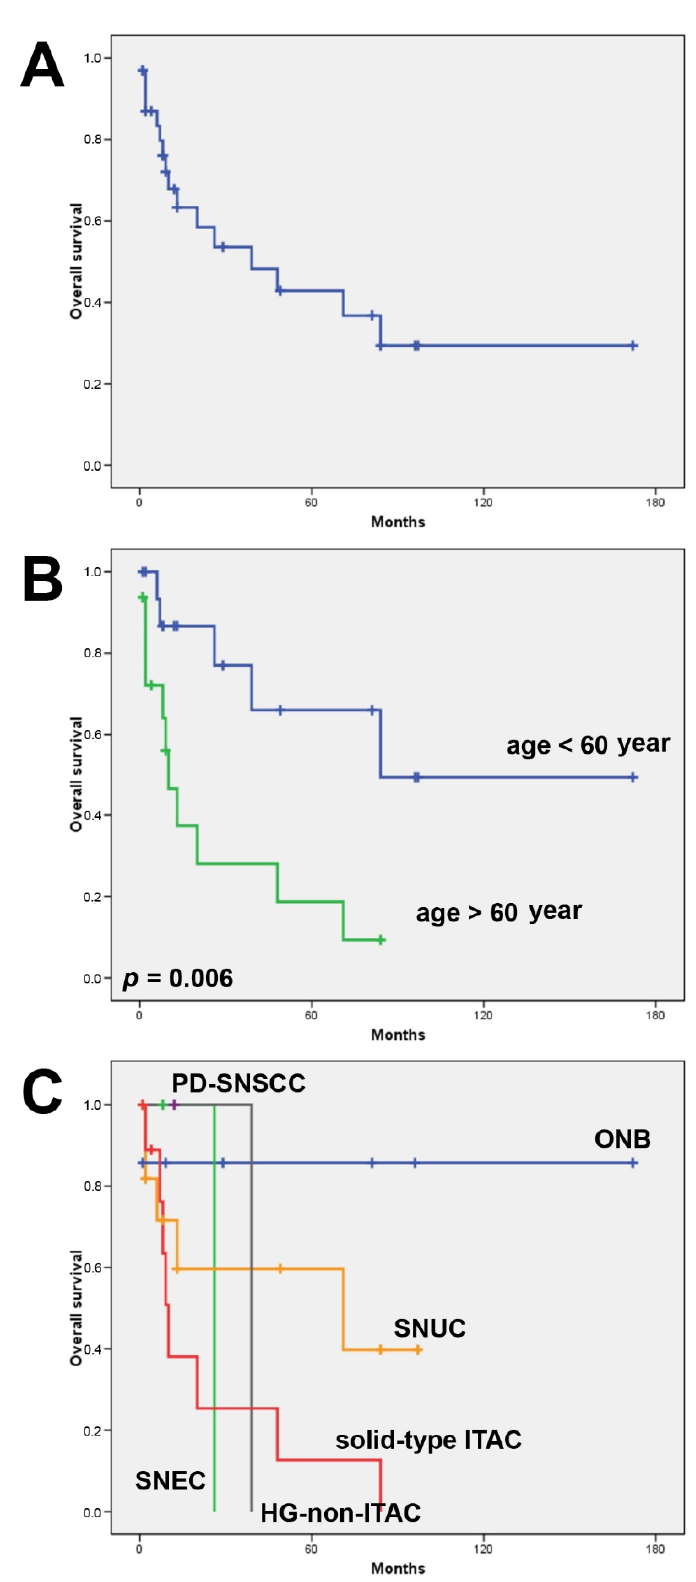
Figure 2. Kaplan–Meier overall survival analysis. All cases ( A ), according to age ( B ) and according to tumor subtype ( C ).